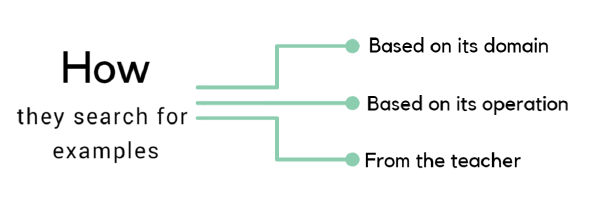
Fig. 2. How novice programmers search for examples